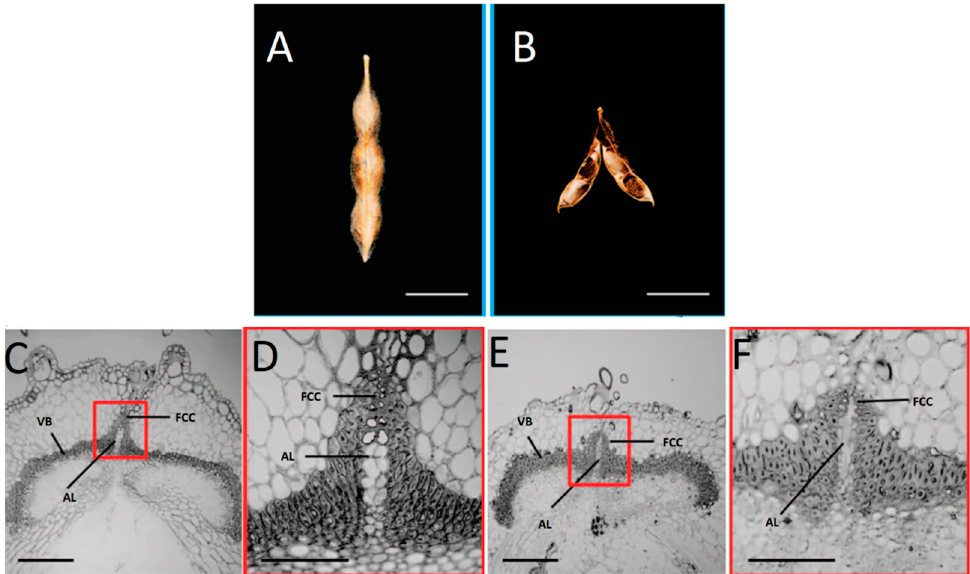
Figure 4. ( A , B ) Representative mature pods of domesticated soybean ( G. max ) ( A ) and wild soybean ( G. soja ) ( B ). ( C – F ) Representative cross-sections (~500 nm) of ventral sutures of domesticated ( C , D ) and wild ( E , F ) soybean pods. ( C , E ) Boxes: Magnified regions shown in ( D , F ). Details show fiber cap cells (FCC) at junctions between two vascular bundle (VB) valves, with adjoining abscission layer (AL). Scale bars: 1 cm, ( A , B ); 200 mm, ( C , E ); 80 mm, ( D , F ) (reproduced with permission from Dong et al. [16]; with modifications).